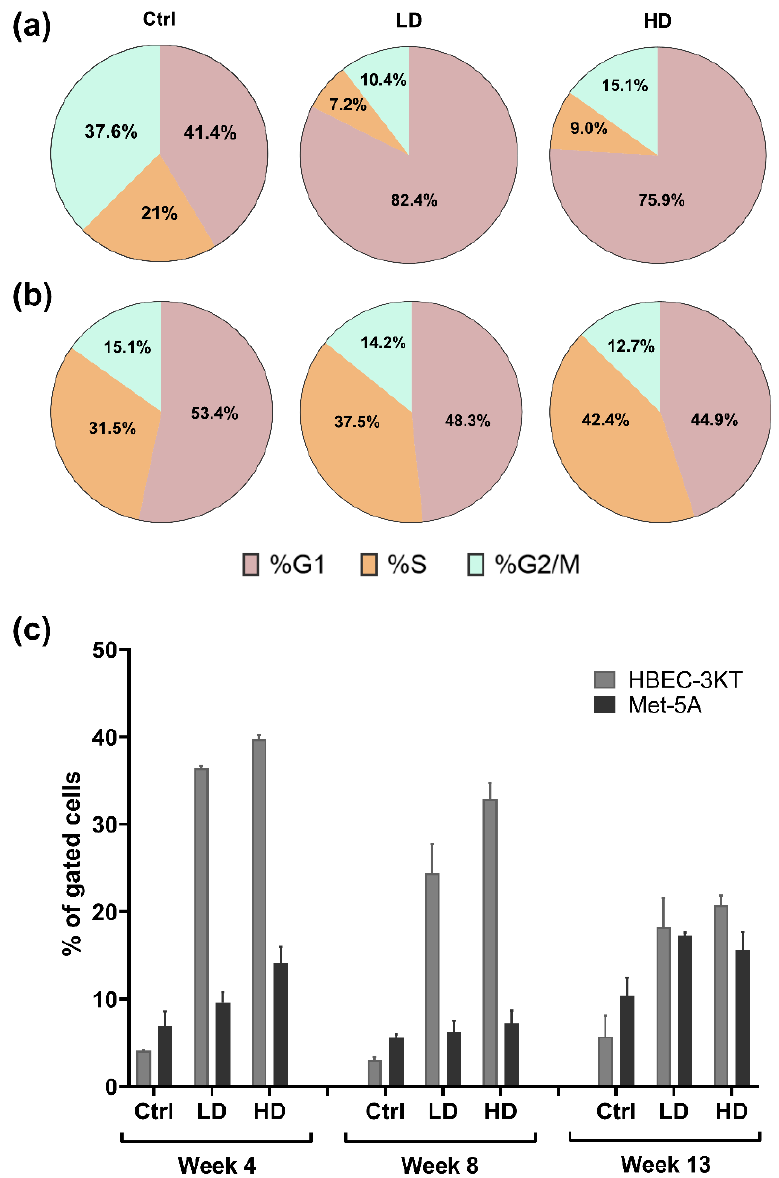
Figure 5. Effects of NM-401-exposure on cell cycle and apoptosis/necrosis. Cell cycle and apoptosis were assessed by flow cytometry. ( a ) Changes in cell cycle at week 13 of continuous exposure to NM-401 in HBEC-3KT cells. ( b ) Changes in cell cycle at week 13 of continuous exposure to NM-401 in Met-5A cells. ( c ) Apoptotic/necrotic cells at 4, 8, and 13 weeks of exposure to NM-401 in HBEC-3KT and Met-5A cells. Single cells were gated, and data are presented as % of gated cells. Low dose (LD), high dose (HD). Data indicate mean ± SD ( n =